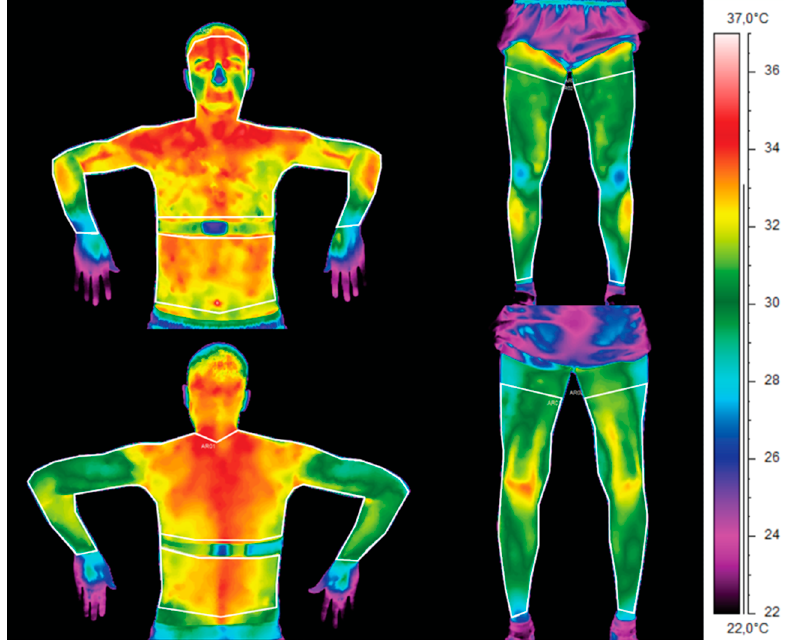
Figure 1. Areas of interest used to calculate the average body surface temperature for a representative athlete.